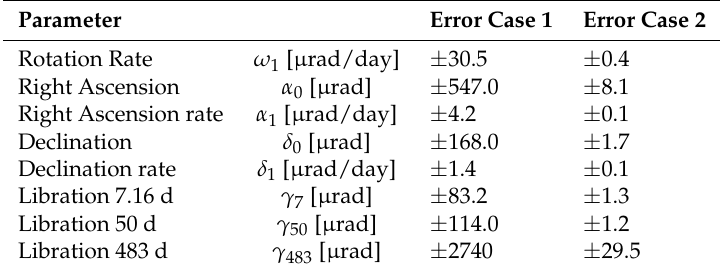
Table 1. Derived measurement uncertainties for Ganymede’s libration amplitudes by using a spherical harmonics approach. Parameter Error Case 1 Error Case 2 Rotation Rate ω 1 [ µ rad/day] ±